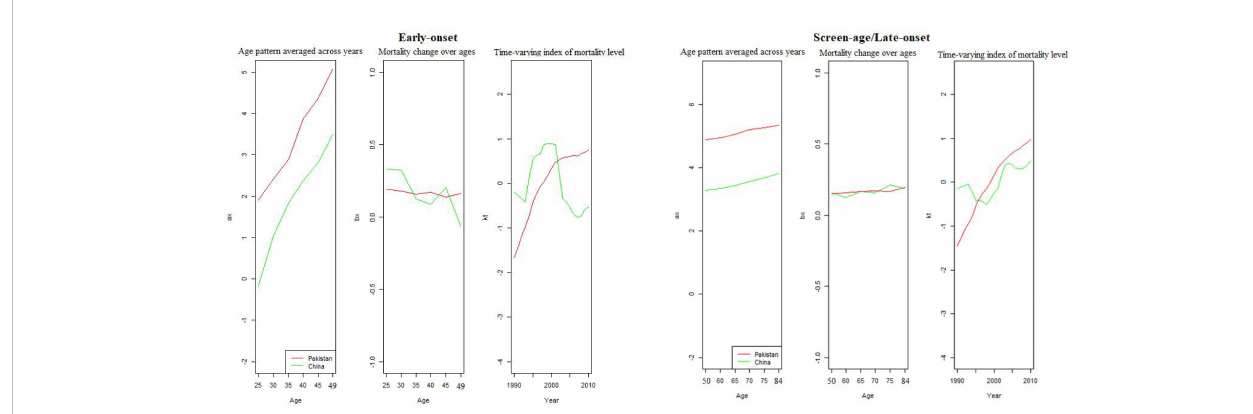
FIGURE 2 Model estimation between the early-onset and screen-age/late-onset population for China and Pakistan.